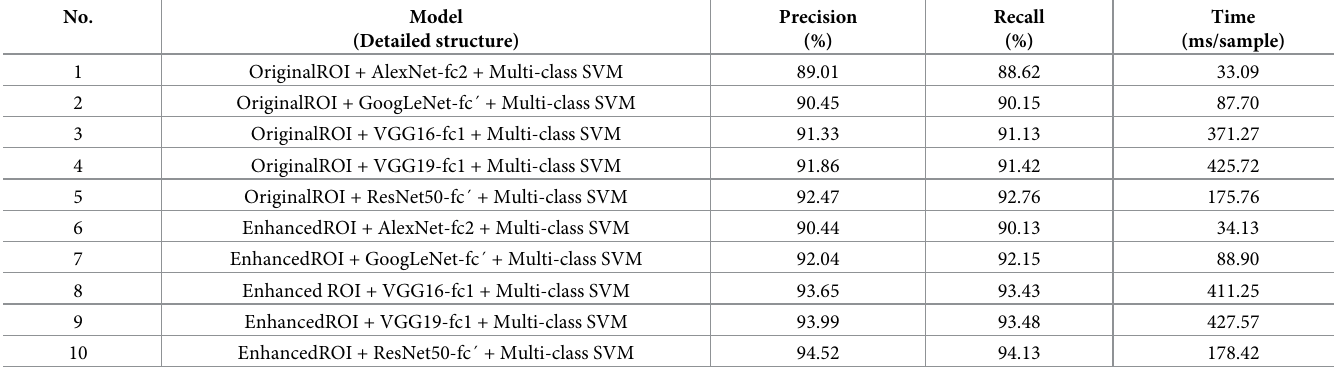
the output from the fully connected layer of the classical CNN, which was proved to have a bet- ter performance in Models 7 to 14, as the input for the multi-class SVM model. The necessary pre-trained models in MATLAB language are also available from https://doi.org/10.6084/m9. figshare.8146283. Because the original ROIs contained a lot of noise, the second experiment (Table 2) was performed to examine the impact of ROI enhancement on the precision and recall rates using Table 2. Effect of ROI enhancement in plankton identification and